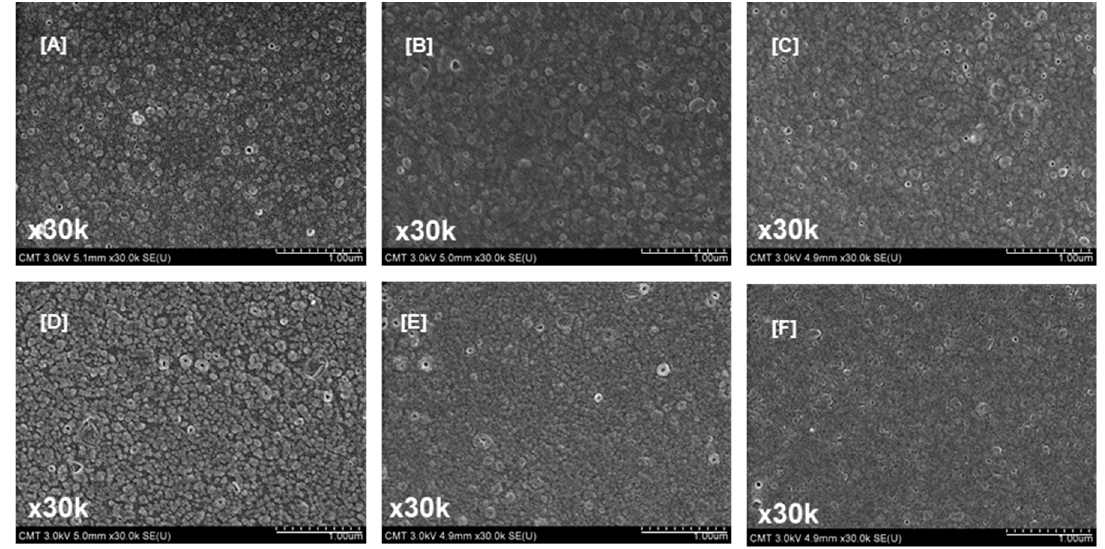
Figure 5. Surface images of thin-film composite membranes prepared using PEG of varying molecular weights: ( A ) TFC–0; ( B ) TFC–PEG200; ( C ) TFC–PEG1k; ( D ) TFC–PEG10k; ( E ) TFC–PEG20k; and ( F )